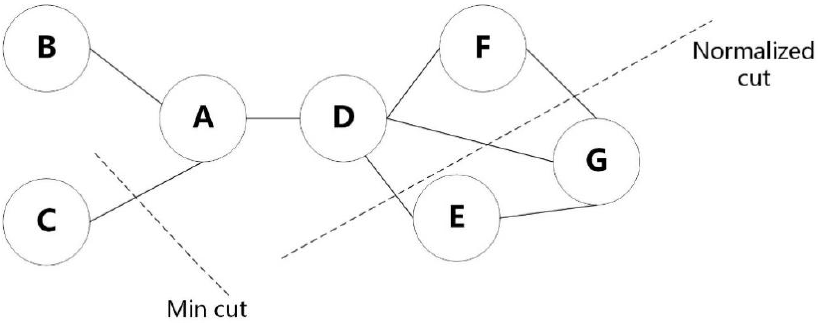
Figure 4. Undirected graph division of spectral clustering: the min cut and normalized